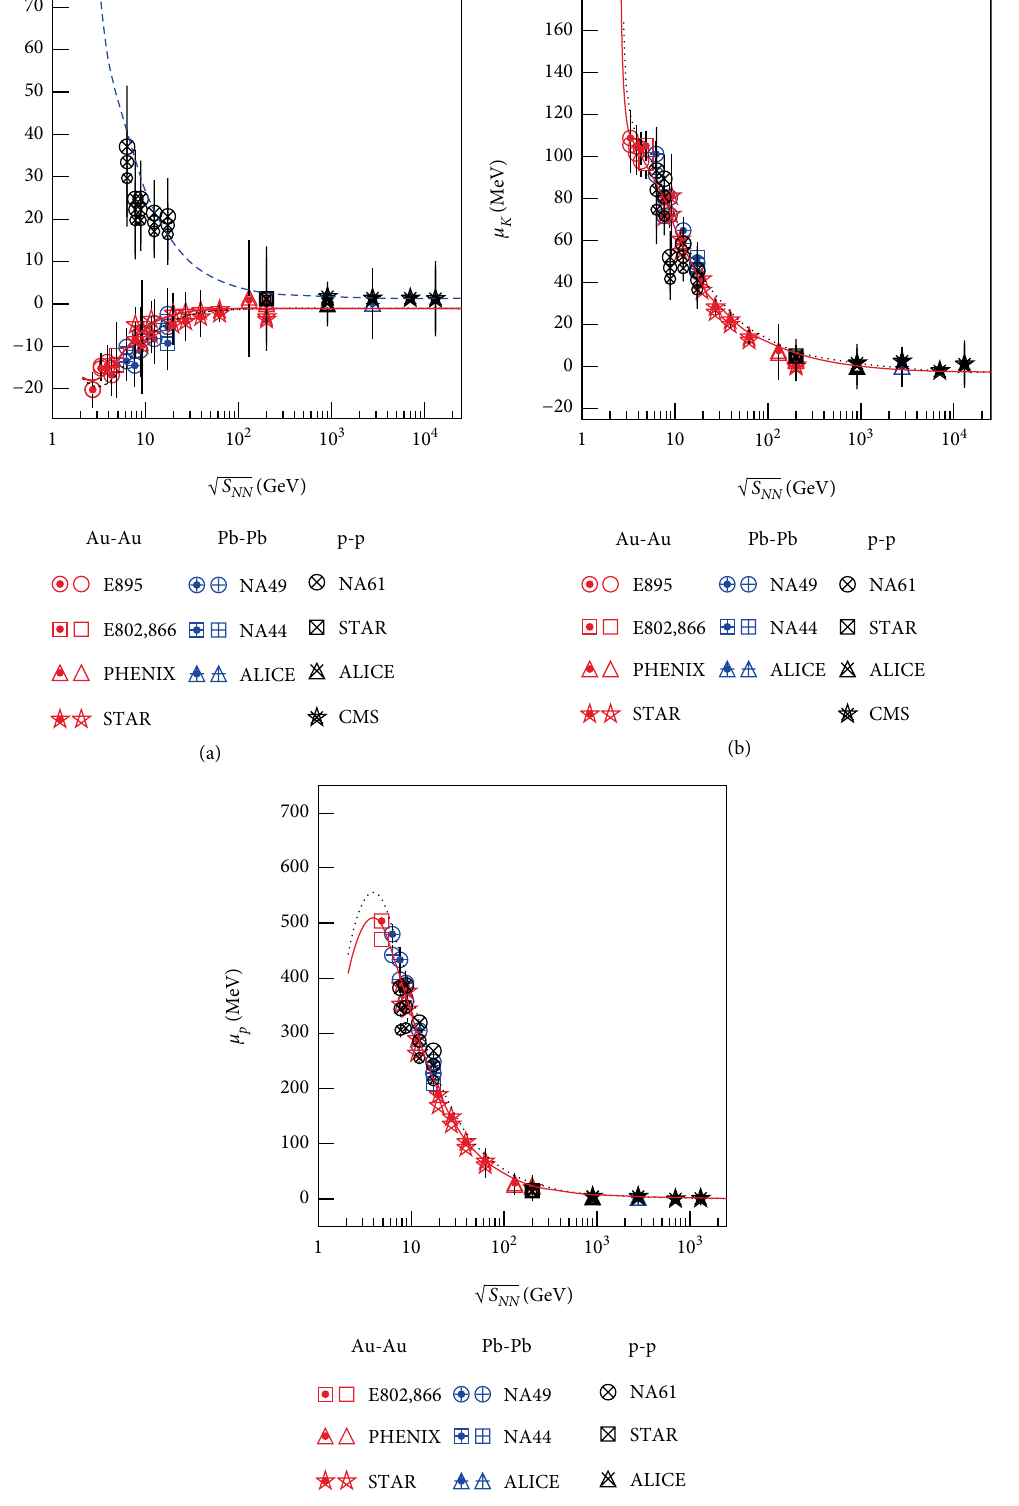
, (b) , and (c) , of (a) , (b) , and (c) produced in mid-(pseudo)rapidity interval in central 𝑝 𝜇 𝜋 𝜇 𝐾 𝜇 𝑝 𝜋 𝐾 collisions, as well as in forward rapidity region in INEL collisions. The 𝑝𝑝 𝑝𝑝 collisions obtained by , , and in Equation (5), respectively. The curves 𝑝𝑝 𝑇 𝑐ℎ 0.9𝑇 𝑐ℎ 0.8𝑇 𝑐ℎ